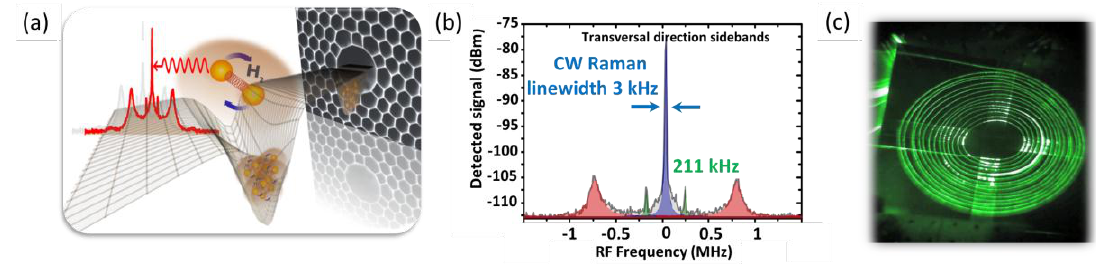
Figure 30. ( a ) Illustration of the molecular trapping experiment. ( b ) Stokes spectrum. ( c ) Moving scatter along the set fiber snapshot (reprinted with permission from Reference [28], Nature,